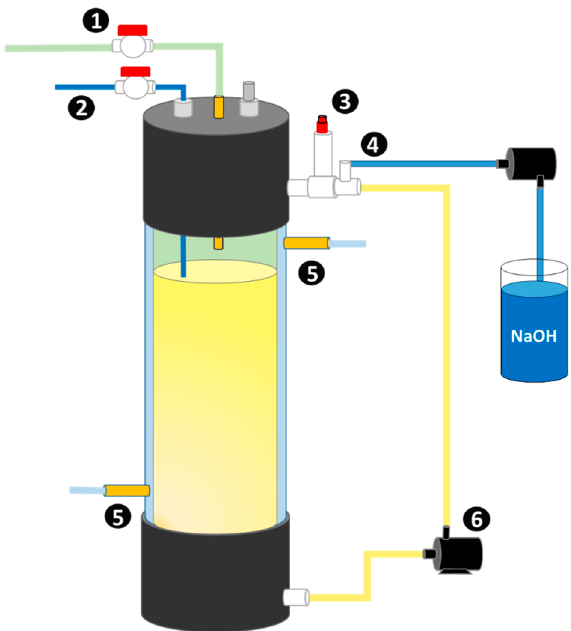
Figure 1. Experimental set-up of the AnSBR digester: (1) biogas output; (2) feeding / drain pipe; (3) pH / ORP sensor; (4) feeding NaOH solution; (5) cooling / heating system and (6) recycling pump.